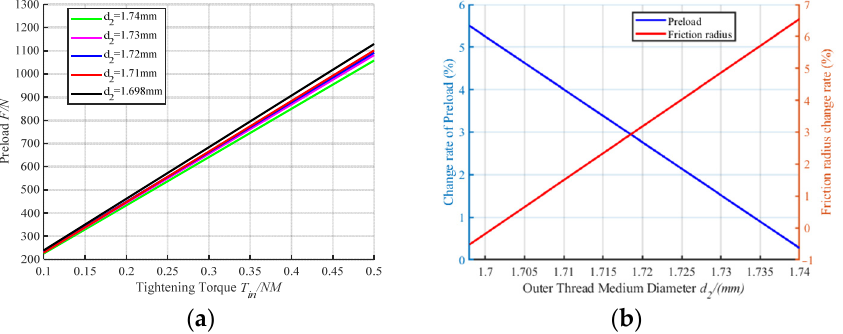
Figure 5. ( a ) Tightening curve under the pitch diameter of thread deviation, ( b ) change curve of